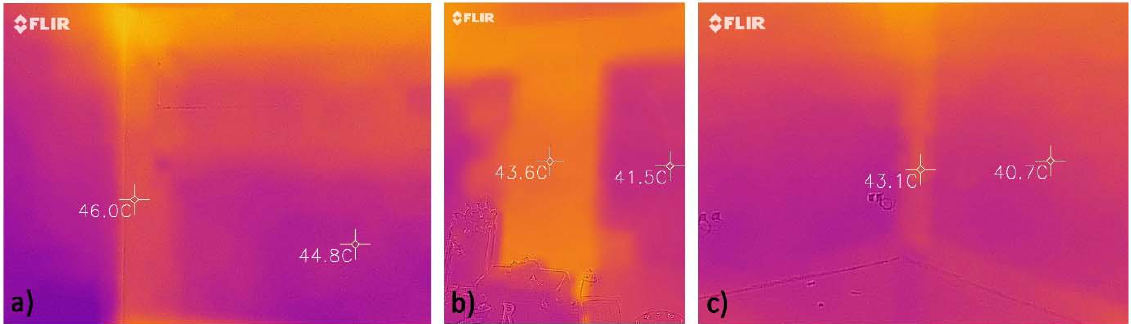
Figure 11. ( a ) Thermal images result for Building-1, ( b ) Building-2, and ( c ) Building-3, showing surface temperature differences evidencing thermal bridging through structural columns and beams.